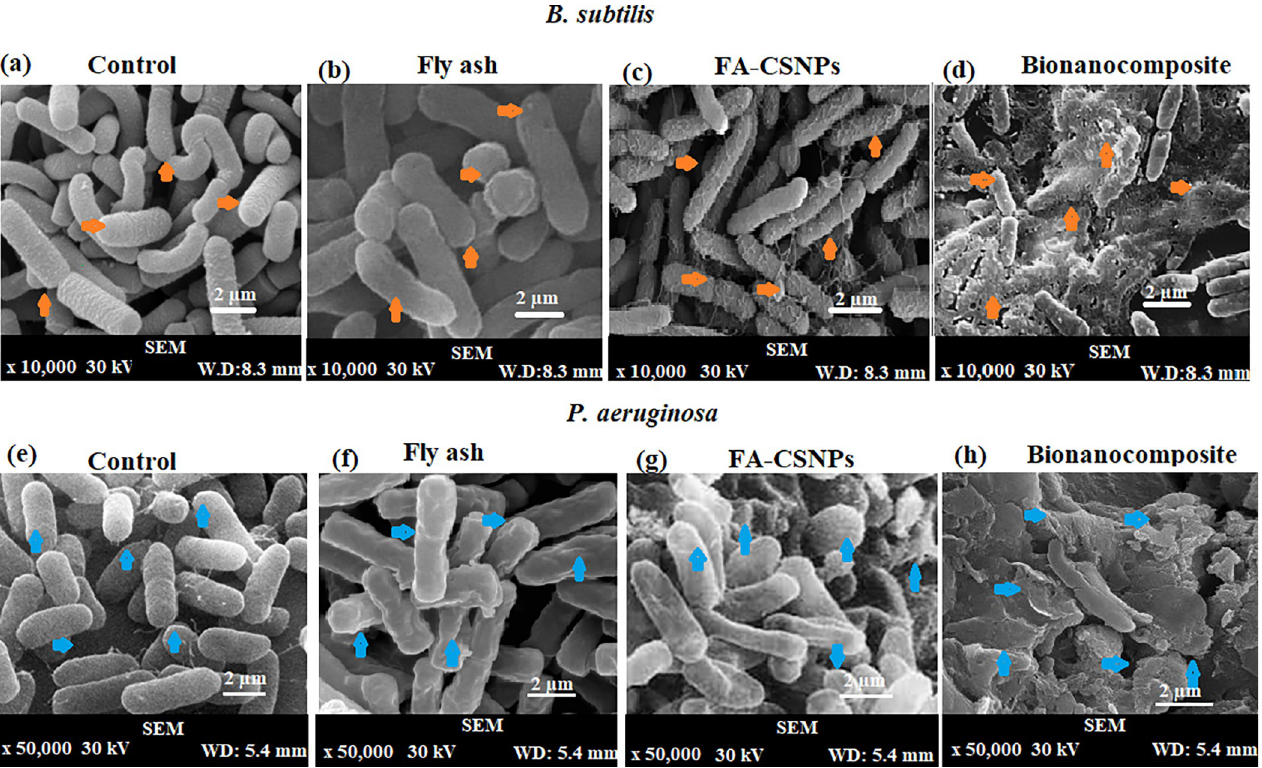
Fig 8. The morphological changes of untreated bacterial cells B . subtilis and P . aeruginosa (a,e) control and treated with (b,f) chitosan, (c,g) fly ash, and (d,h) sunflower oil/FA–CSNPs bionanocomposite under SEM.